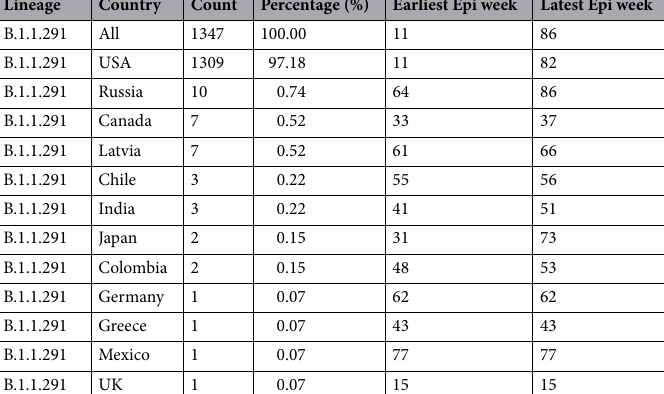
Table 2. Distribution of the Pango Lineage B.1.1.291 in different countries. Epi Week: the week since COVID- 19 pandemic.